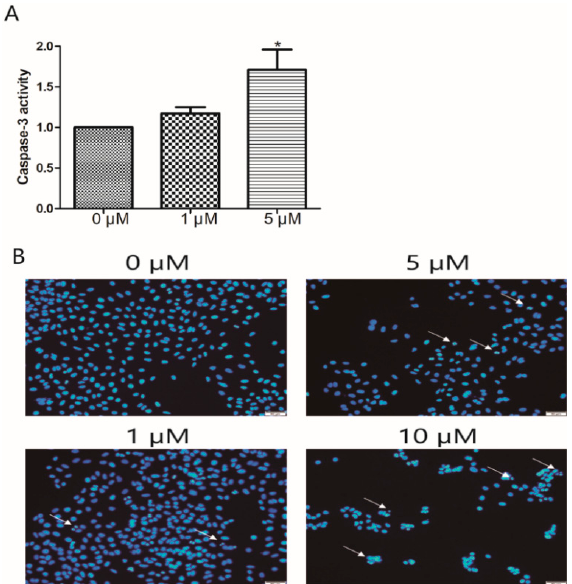
Figure 3. Compound 15 treatment induces A549 cell apoptosis. ( A ) Activation of caspase-3 by compound 15 (0, 1, 5 μ M). ( B ) Morphology of nuclei in A549 cells treated with compound 15 (0, 1, 5, 10 μ M), stained by Hoechst 33258, and observed under a fluorescence microscope. The white arrows represent apoptotic cells. Data are expressed as means standard deviation from three independent experiments. * p < 0.05, ** p < 0.01 compared with the control group.